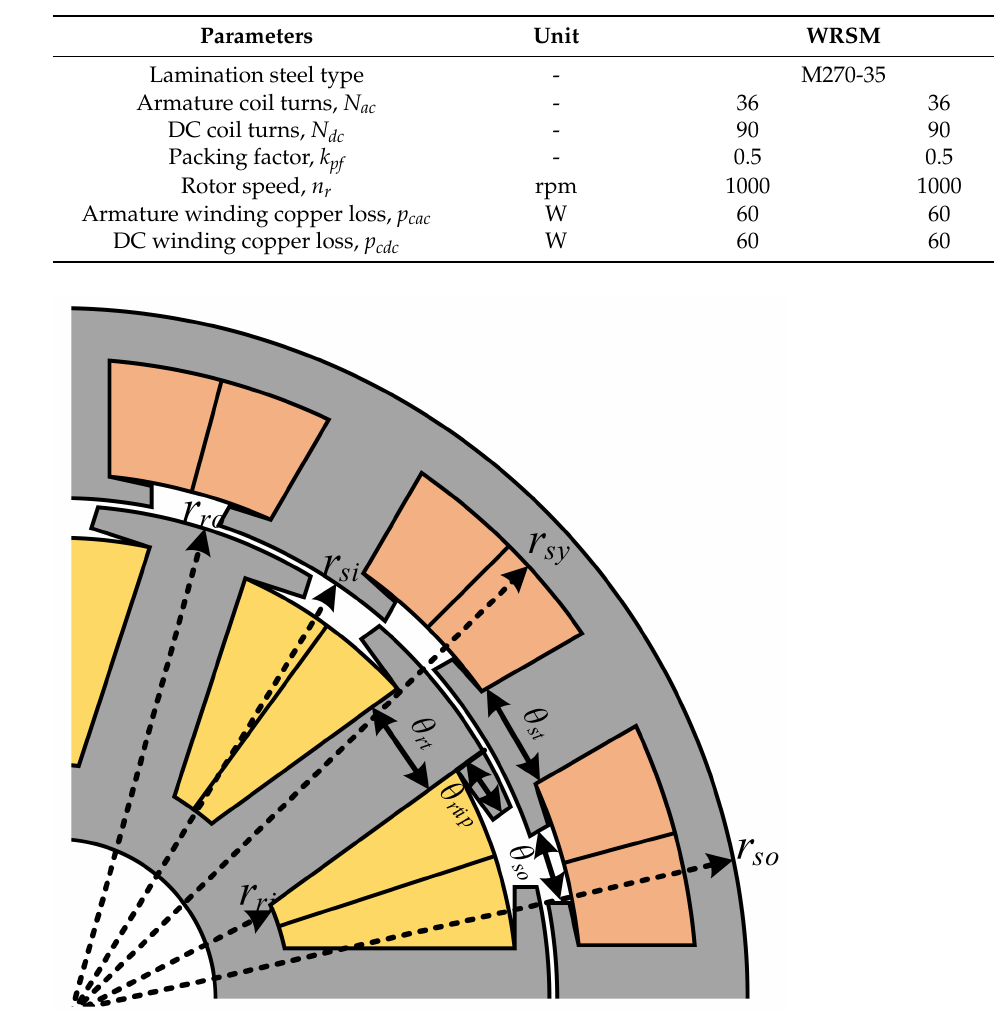
Figure 2. Linear illustrations of the WRSM